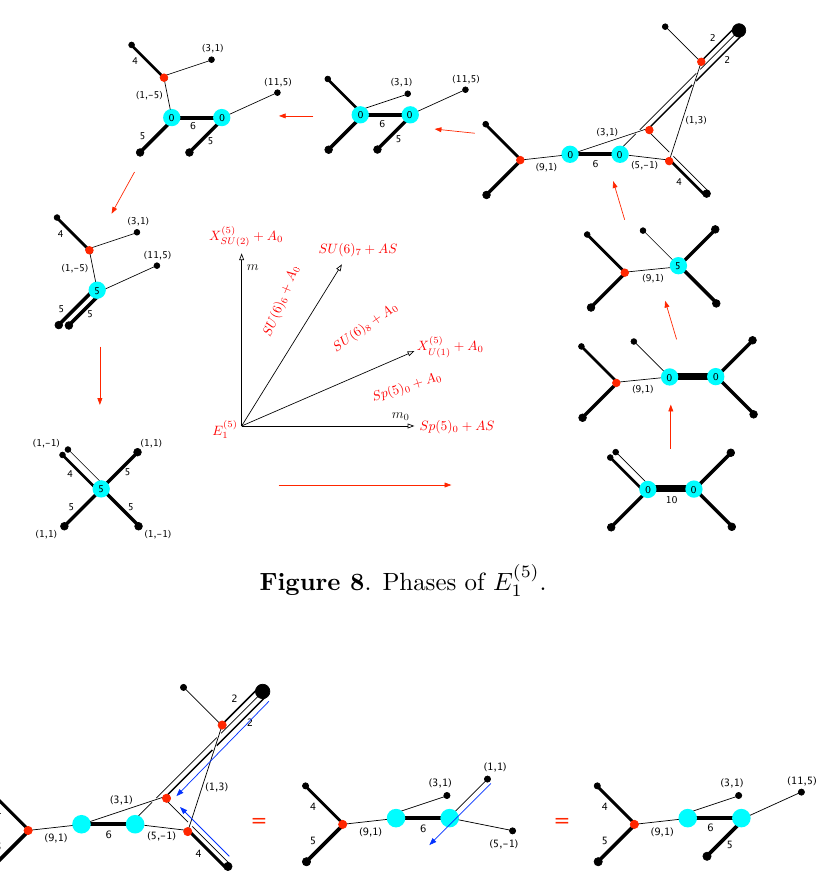
Figure 9 . Equivalent webs for SU(6) 8 with a massive antisymmetric hypermultiplet.